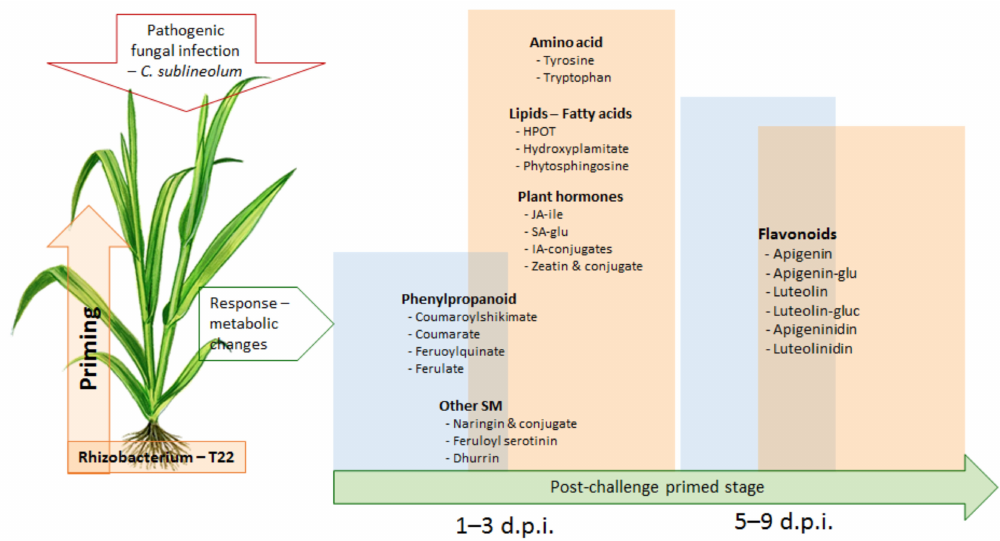
Figure 6. A contextual summary of results obtained in this study: A schematic diagram of comparative metabolic changes in PGPR primed and naïve sorghum plants during a post-challenge stage with the hemibiotrophic fungal pathogen, C. sublineolum . Following the rhizobacterium ( P. alvei ) application (24 h), sorghum plants were inoculated with C. sublineolum (blue = naïve plants and orange = primed plants). The primed plants showed a strong resistance to the fungal infection (symptomatology results), which was metabolically characterised by increased levels of aromatic amino acids, lipid components and phytohormones in the early phase of the post-challenge primed period: 1–3 d.p.i. Other metabolic changes observed during the post-challenge primed stage spanned di ff erent metabolic pathways particularly those involved in phenylpropanoid—and flavonoid